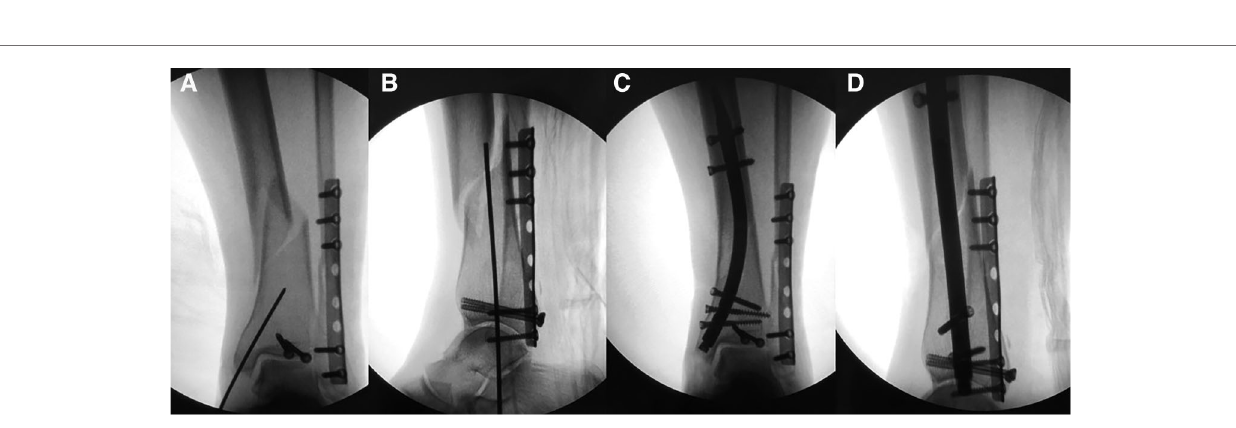
FIGURE 2 | ( A,B ) fi rstly, the posterior lateral ankle approach was taken, and plates and tension screws were applied to fi x the fi bula and posterior ankle fractures (RTN guide pins at the medial ankle site), and the orthogonal and lateral fi lms were positioned under intraoperative fl uoroscopy, respectively; ( C,D ) a medial minimally invasive incision was used for RTN placement to fi x the tibial metaphysis fracture, and the orthogonal and lateral fi lms were taken, respectively.